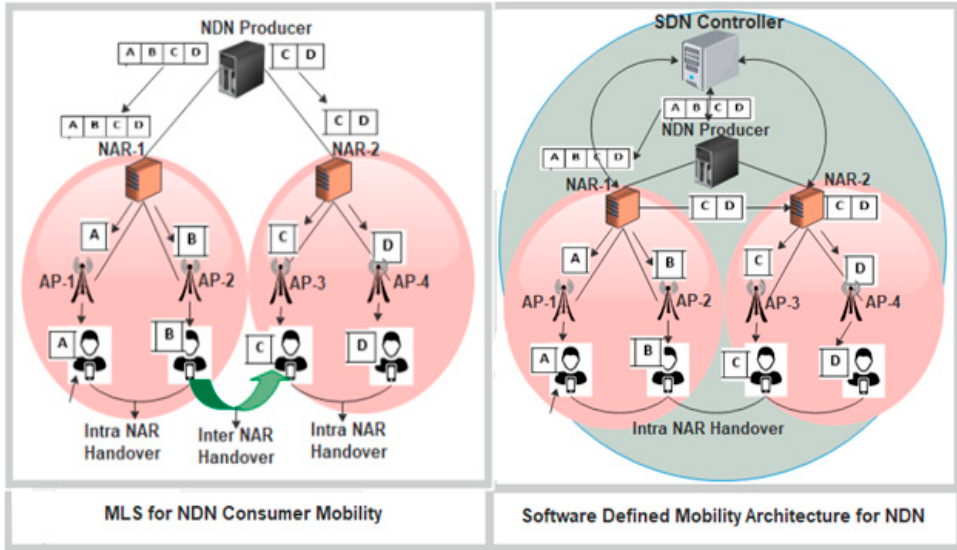
Figure 1. Problem statement and proposed solution.